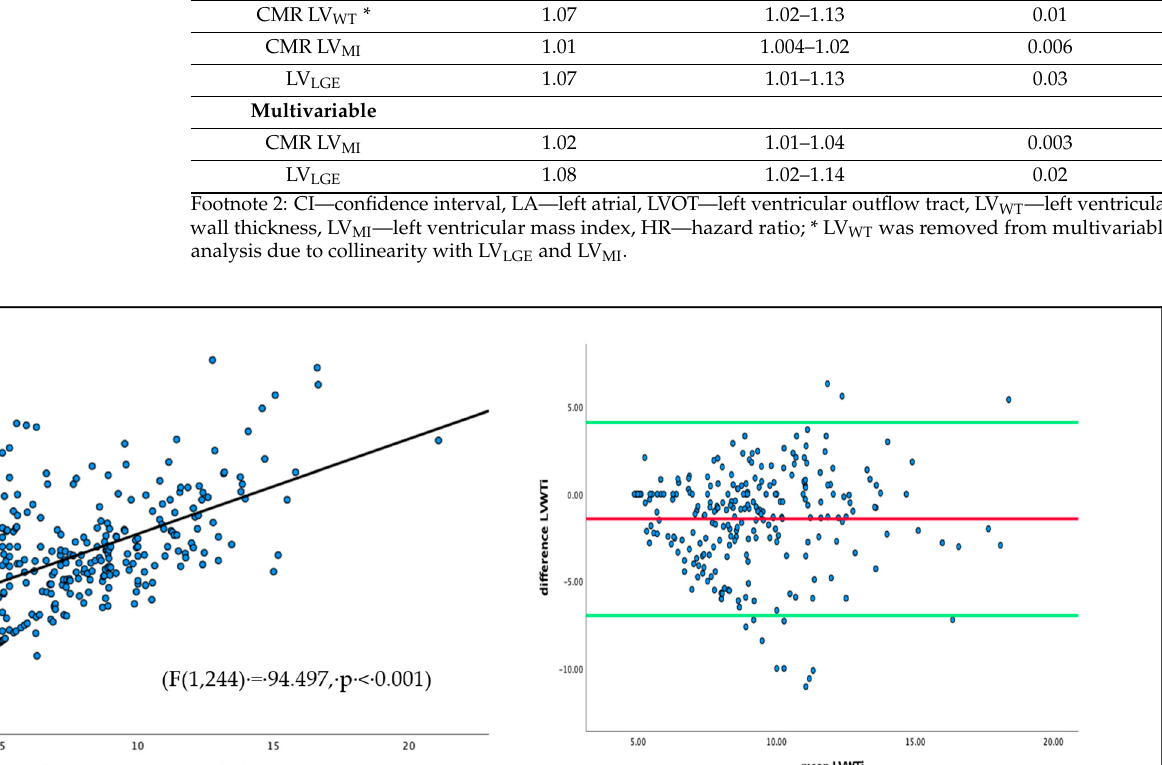
Figure 5. Panel ( A ): Correlation between LV WT measured between CMR and TTE. Panel ( B ) : Bland–Altman plot of indexed LV WT correlation between TTE and CMR. Mean = − 1.43, 95% CI = − 6.97–4.12, p = 0.44. g/m 2 compared to LV MI > 85 g/m 2 (78.7% vs. 56.3%, p =0.003, HR 2.16, 95% CI = 1.31–3.58, p = 0.003) (Figure